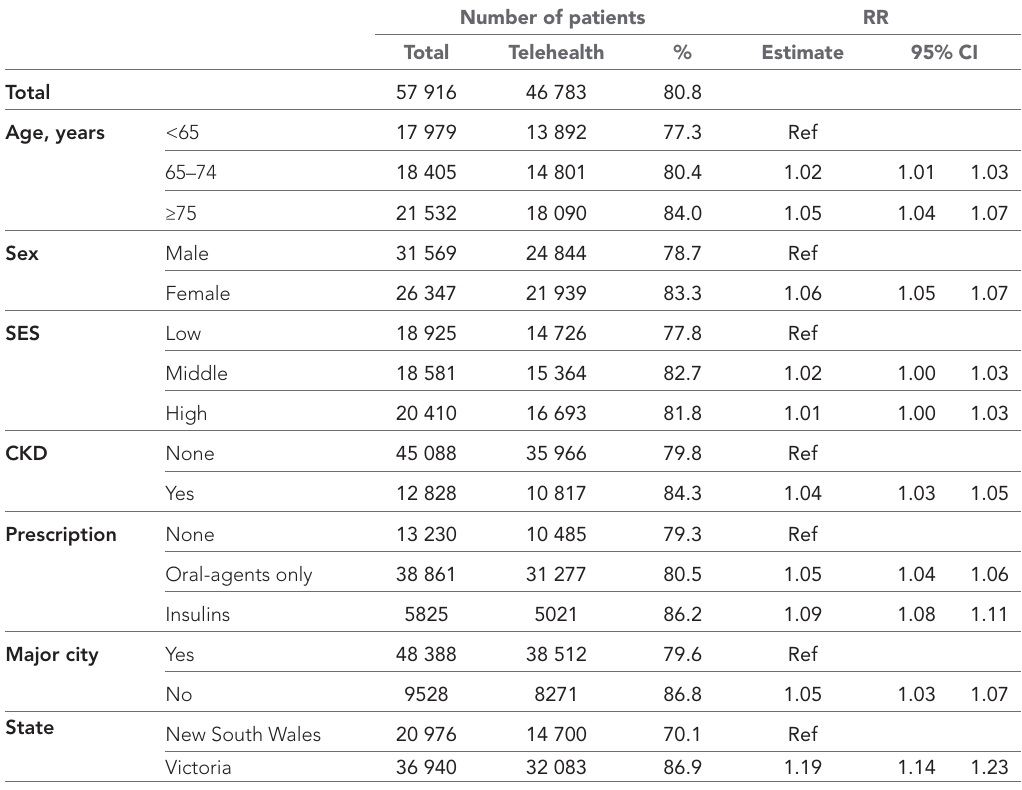
Table 1 The characteristics of patients who had a teleconsultation during the COVID- 19